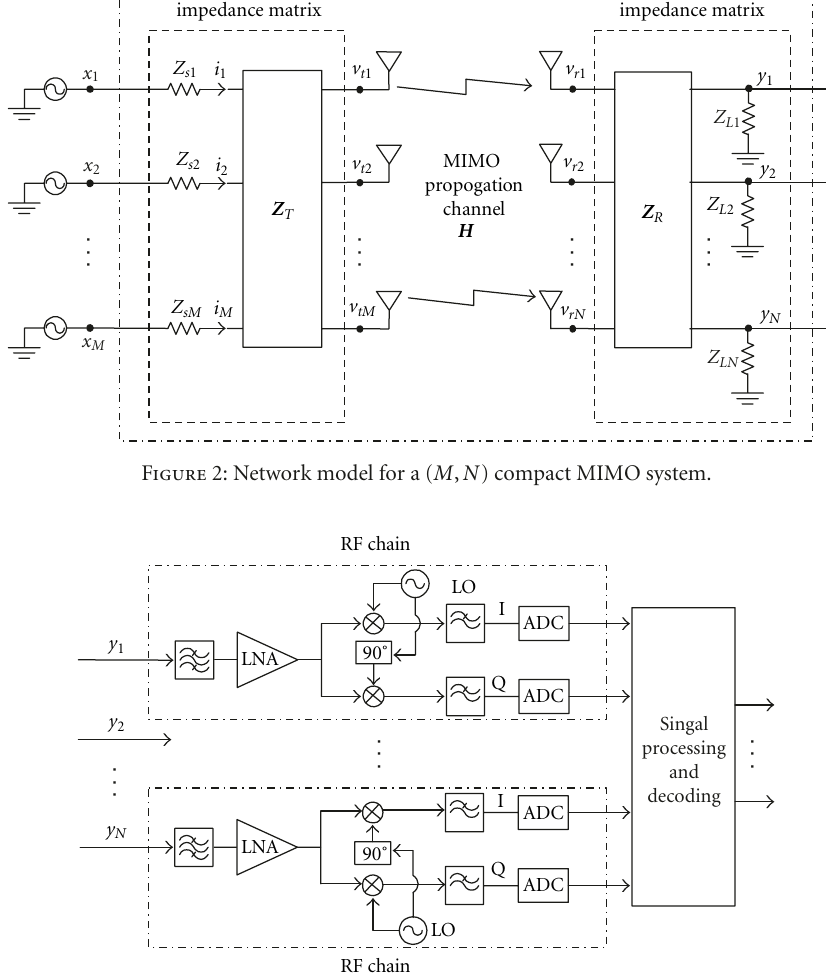
Figure 3: RF chains at the receiver